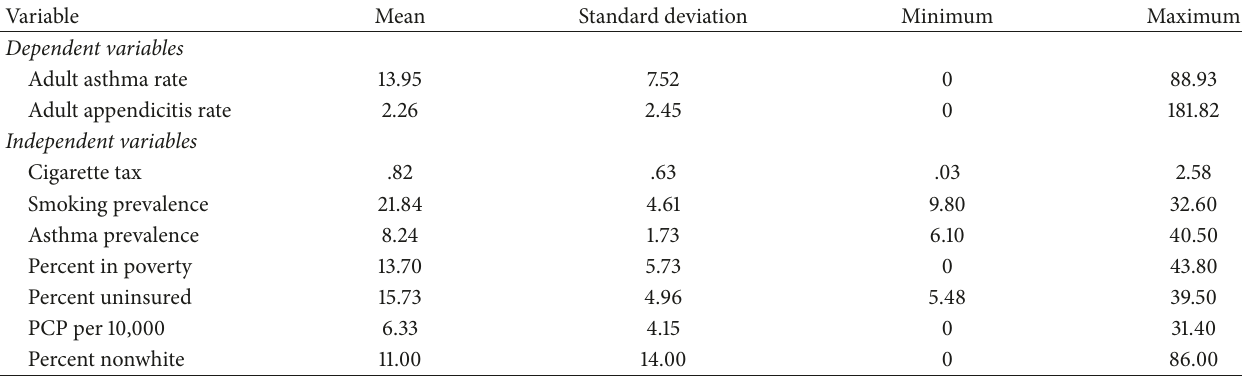
Table 1: Descriptive statistics for continuous study variables (county level data).